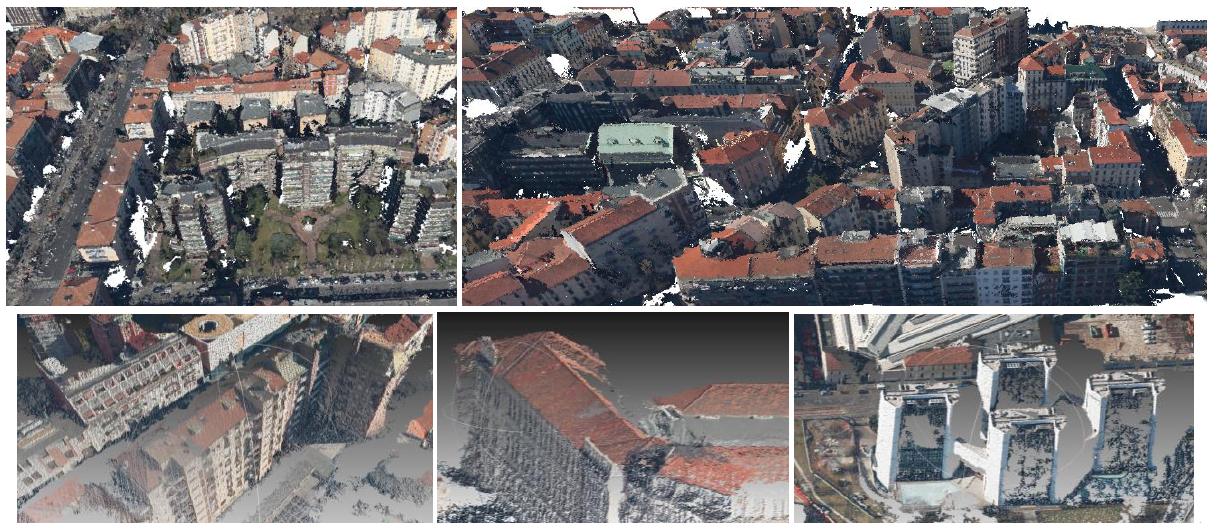
Figure 8. Examples of dense point clouds derived from oblique aerial datasets. Complex façades with repeated patterns, uniform texture and large glass areas are leading to more noisy and unpleasant results (lower